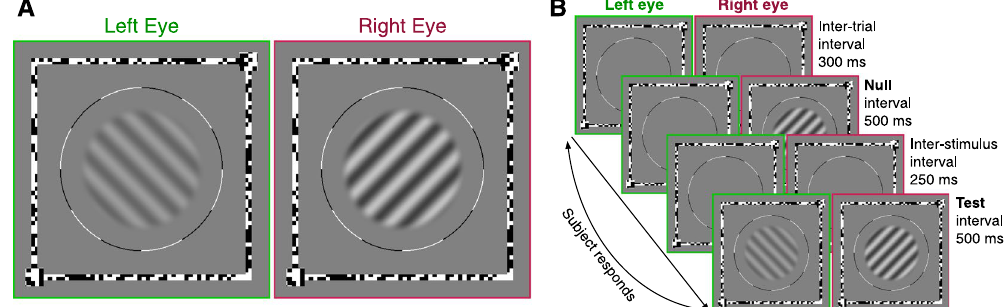
Figure 4. Panel A shows an example dichoptic pair of the stimuli used in this study. The two stimuli were presented separately to the two eyes using frame-interleaving. In this example, the target was a + 45° oblique grating in the right eye. The dichoptic mask was a − 45° oblique grating in the left eye. Panel B shows the sequence of stimuli shown in a single trial. In this example, the target was shown to the left eye in the second